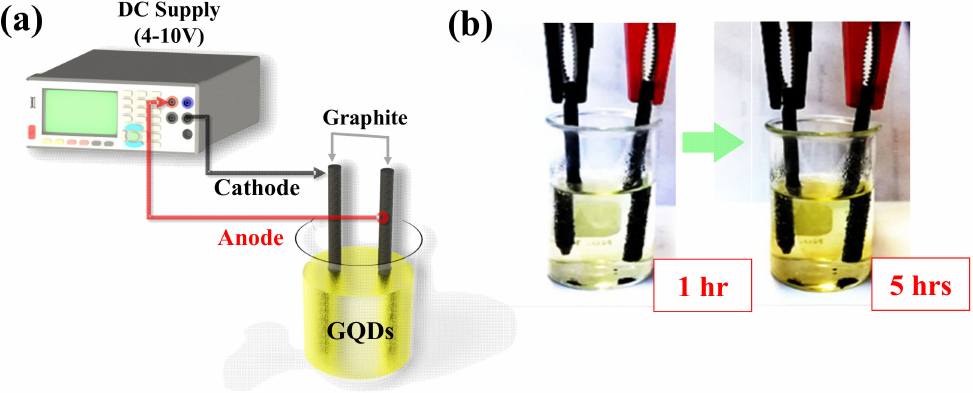
Figure 1. ( a ) Schematic setup of GQDs synthesis in the solution-based form via the electrochemical process and ( b ) progress of GQDs synthesis at 1 h to the finished process of 5